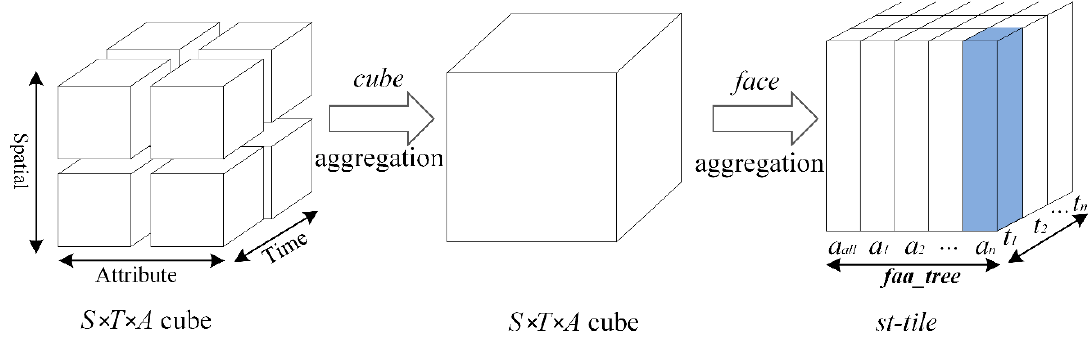
Figure 7. The illustration of a spatio-temporal Tile.